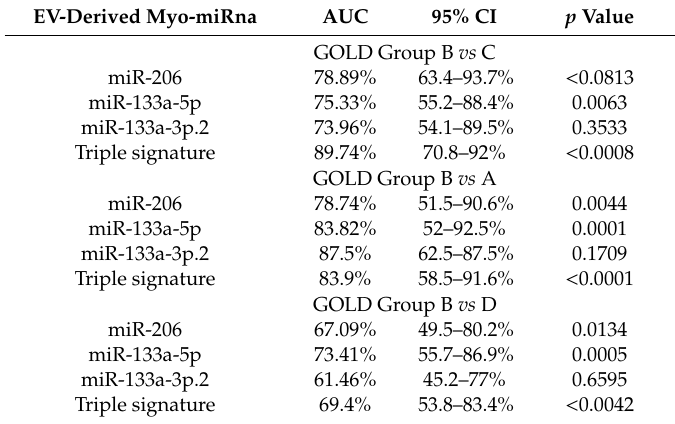
Table 2. Statistical analysis of detectable striated muscle-specific microRNAs from plasma-derived extracellular vesicles and for triple signature in patients with chronic obstructive pulmonary disease (COPD).